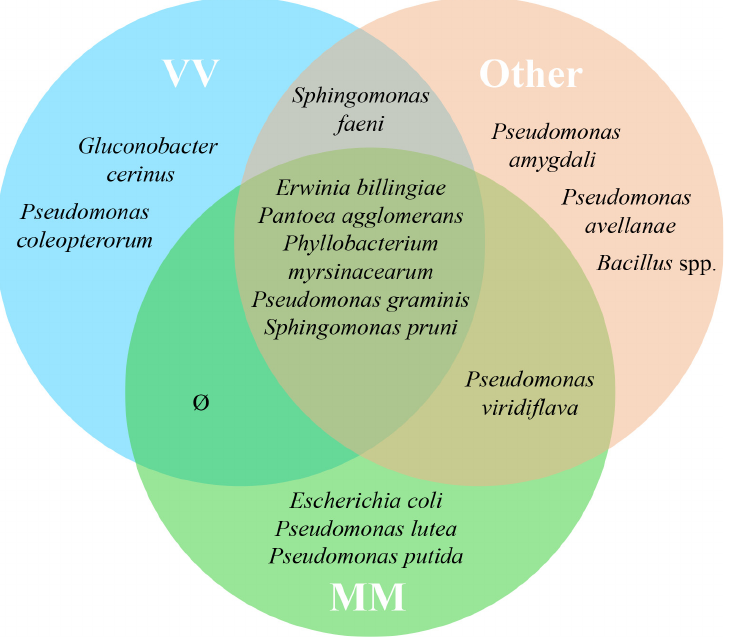
Figure 3. Venn diagram representing shared taxa of bacteria found on grape surface from ten Portuguese vineyard parcels from different regions/sub-regions, Monção and Melgaço (green area), Vinho Verde region (blue area) and Other (red area). Only taxa that are common to 100% of the parcels from a specific group (MM, VV or Other) are represented.